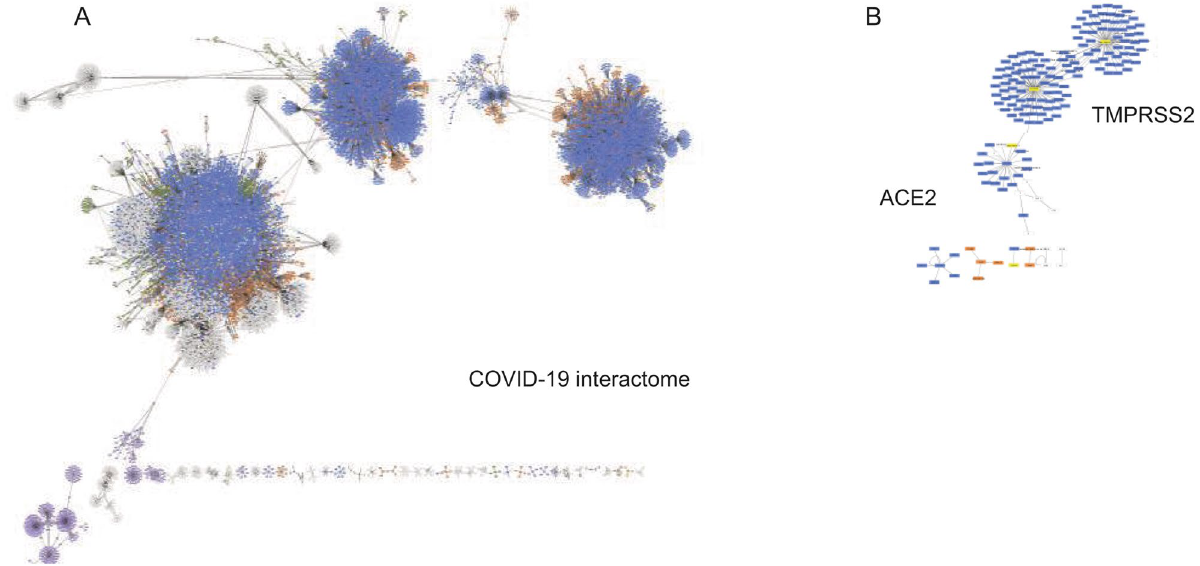
Figure 1. Networks formed by SARS-CoV-2 interactors. Cluster structures of the networks are shown. The merged network formed by SARS-CoV-2 interactors and built with data from databases mentioned in the text is shown ( A ). The network formed by ACE2 and TMPRSS2 is shown ( B ). Compare the structure of the COVID- 19 networks built with data retrieved from each database separately (Supplementary Figure S1), for illustration of contributions of databases to the merged network. The panels A and B of this figure shows cluster structure of the network; to zoom-in on identifiers of nodes and edges, use the “Main merged Network” in the Cytoscape Session file (.cys) (Supplementary File S1 at https ://figsh are.com/artic les/onlin e_resou rce/Cance r_and_COVID -19_syste ms_biolo gy_Suppl _File_S1/12793